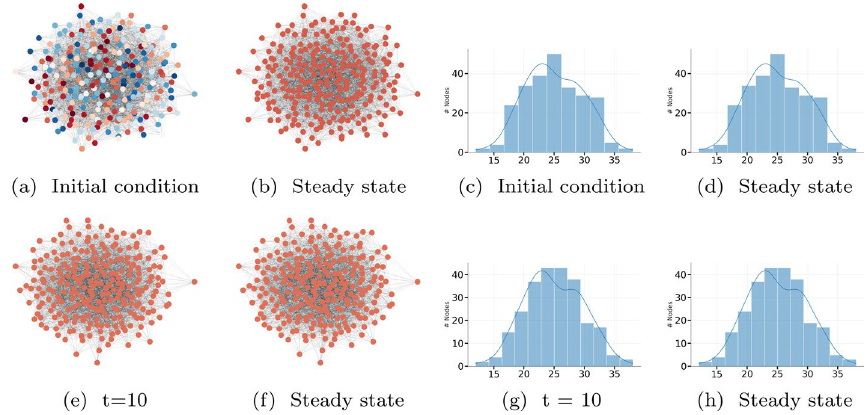
Fig. 10 Example of the effects of the adaptive topology on the Algorithmic Bias Model on Simplicial Complexes on the Erdős–Rényi graph. An example of the effects of the adaptive topology on the Algorithmic Bias Model on Simplicial Complexes on the Erdős–Rényi graph for ǫ = 0.2 , p r ∈ { 0.0,0.5 } and γ = 0.0 . The convergence towards consensus is faster and is always reached before the network can cluster around different opinions